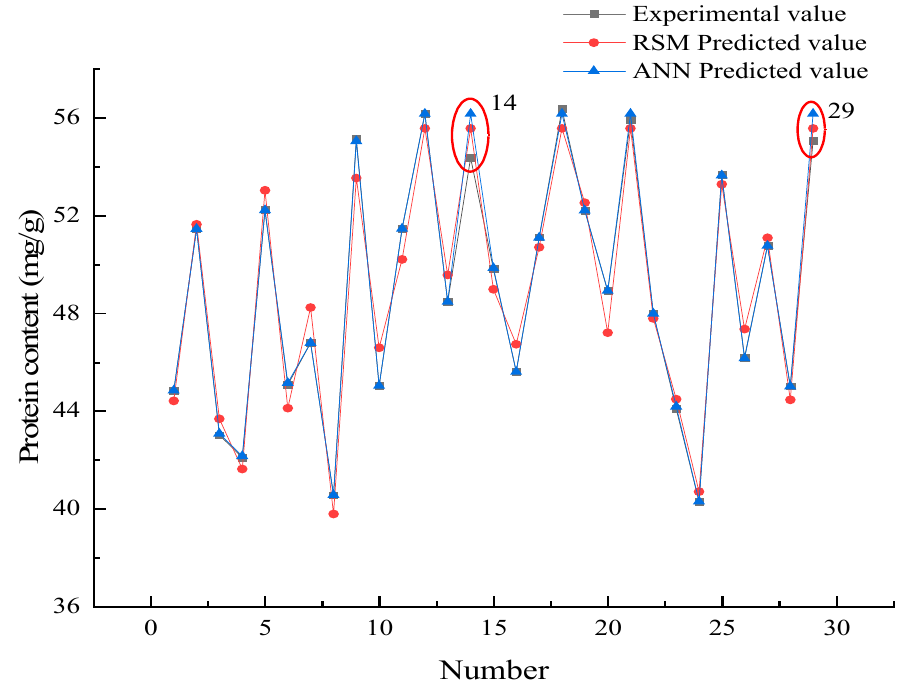
Figure 7. Comparison of the predicted data and real data. Table 5. Comparison and verification of different models to extract